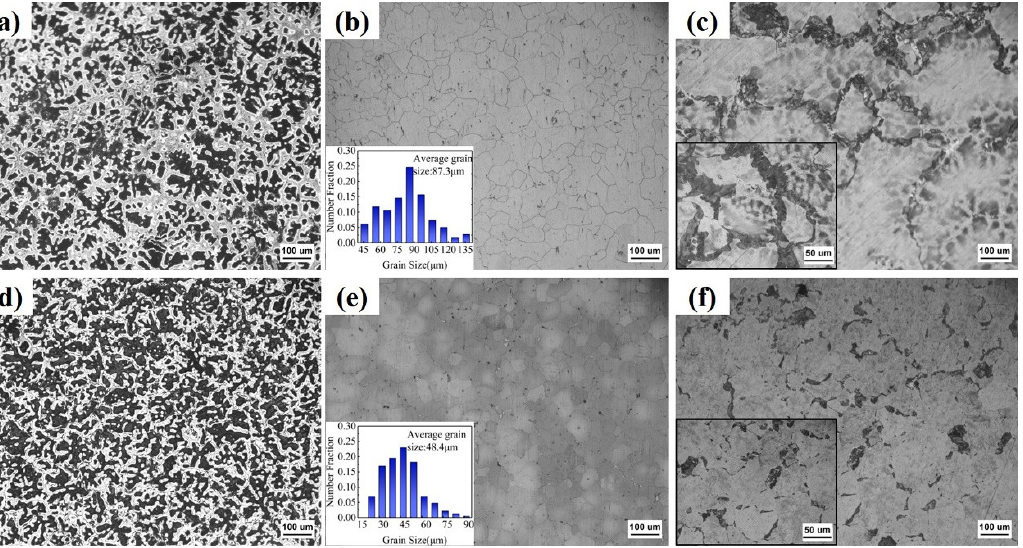
Figure 1. Microstructure of AZ91 and AZ91-CaO alloys as cast and under different heat treatment processes: ( a ) AZ91-Cast, ( b ) AZ91-T4 ( c ) AZ91-T6, ( d ) AZ91-CaO-Cast, ( e ) AZ91-CaO-T4, ( f ) AZ91-CaO-T6.